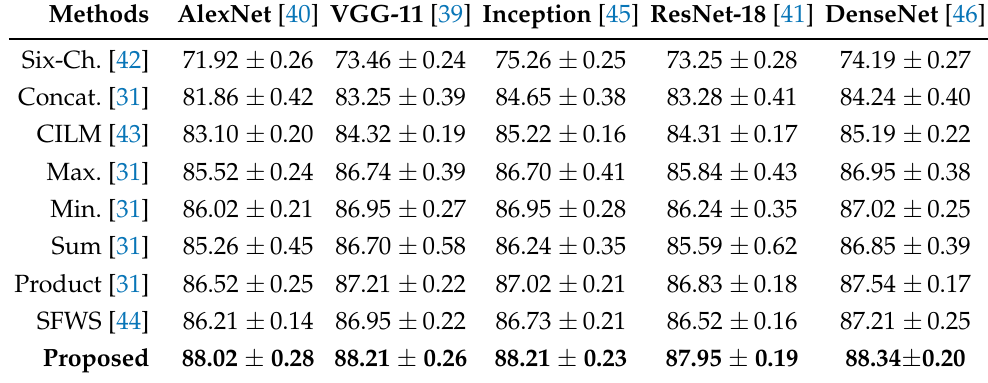
Table 6. Classification accuracy (%) ± STD using different fusion methods on CV-BrCT.